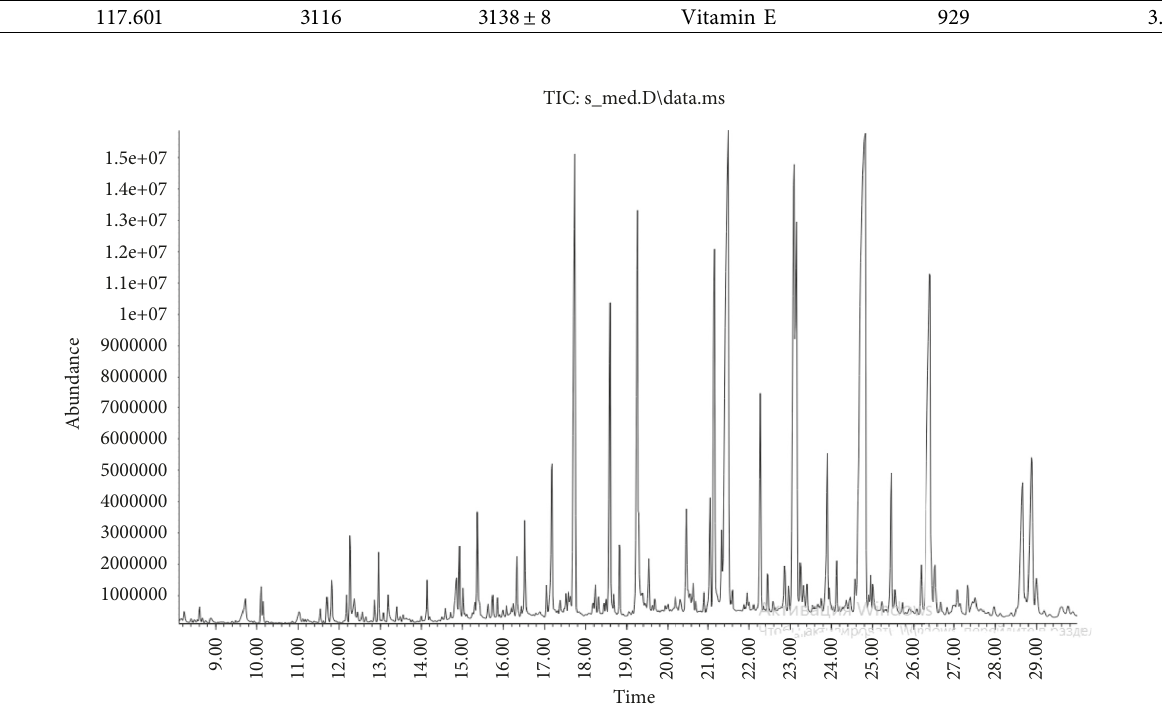
Figure 1: Chromatogram of the CO